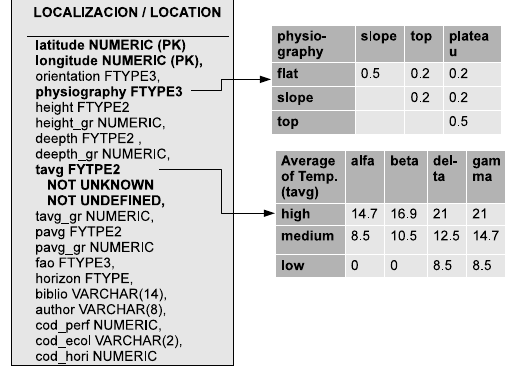
Fig. 4. Partial example of land characteristics database